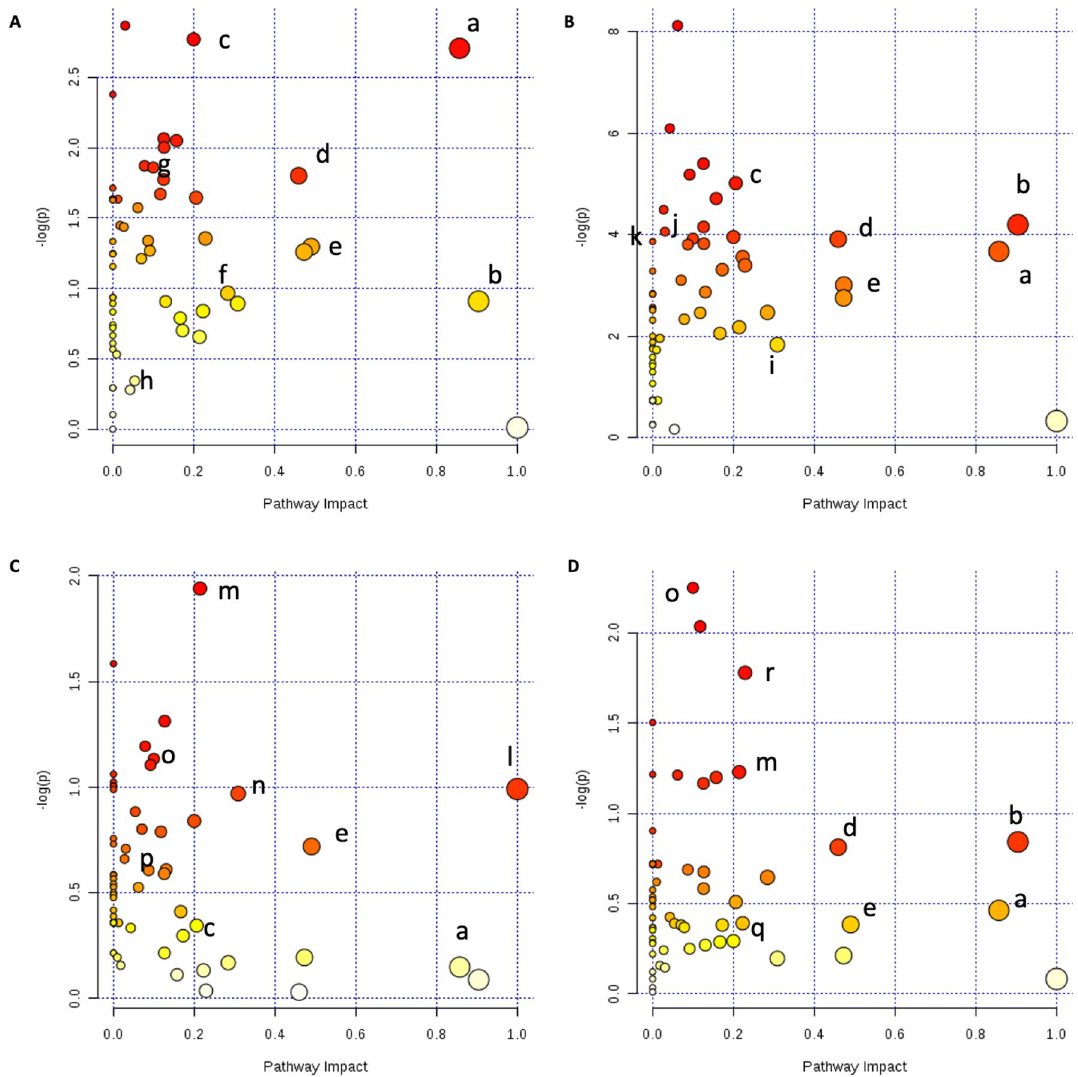
Figure 5. Gut microbial metabolic pathway analysis on cecum samples. Female PBS versus B0 ( A ); female PBS versus B20 ( B ); male PBS versus B0 ( C ) and male PBS versus B20 ( D ). Some representative metabolic pathways were assigned arbitrary lower case letters in alphabetical order and the full names are shown in Table